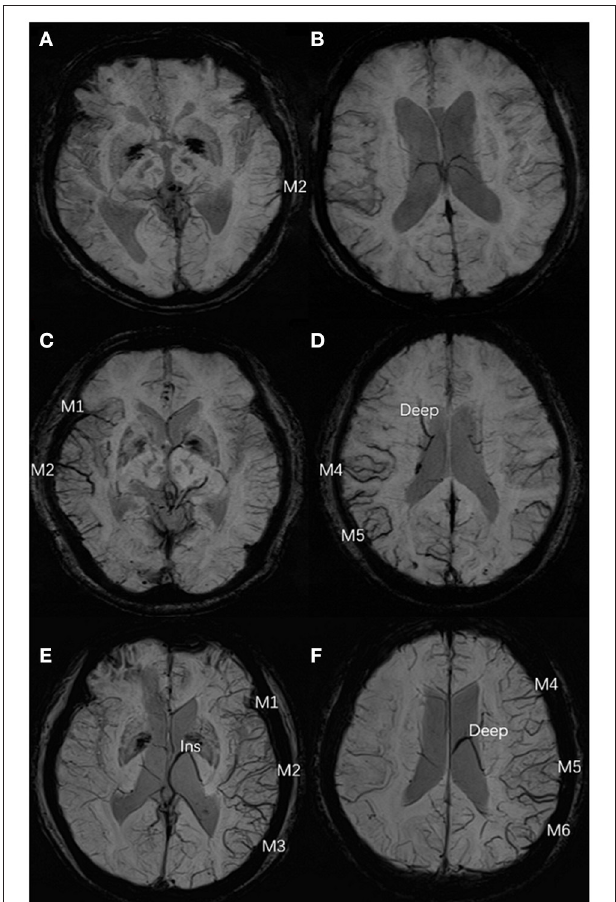
FIGURE 1 | Three typical cases of ACVS, graded as “mild,” “moderate,” and “severe” (A,B) In the left hemisphere, ACVS in M2 was evident on SWI and defined as “mild ACVS.” (C,D) In the right hemisphere, ACVS in M1 and M2 and M4, M5, and Deep were evident on SWI, and defined as “moderate ACVS.” (E,F) In the left hemisphere, ACVS in M1, M2, M3, and Ins and M4, M5, M6, and Deep were evident on SWI and defined as “severe ACVS”. AIS, acute ischemic stroke; ACVS, asymmetric cortical vein sign; M1, anterior MCA cortex; M2, MCA cortex lateral to the insular cortex; M3, posterior MCA cortex; M4, M5, M6, the anterior, lateral and posterior MCA territories immediately superior to M1, M2 and M3, respectively; Deep, deep white matter; Ins,